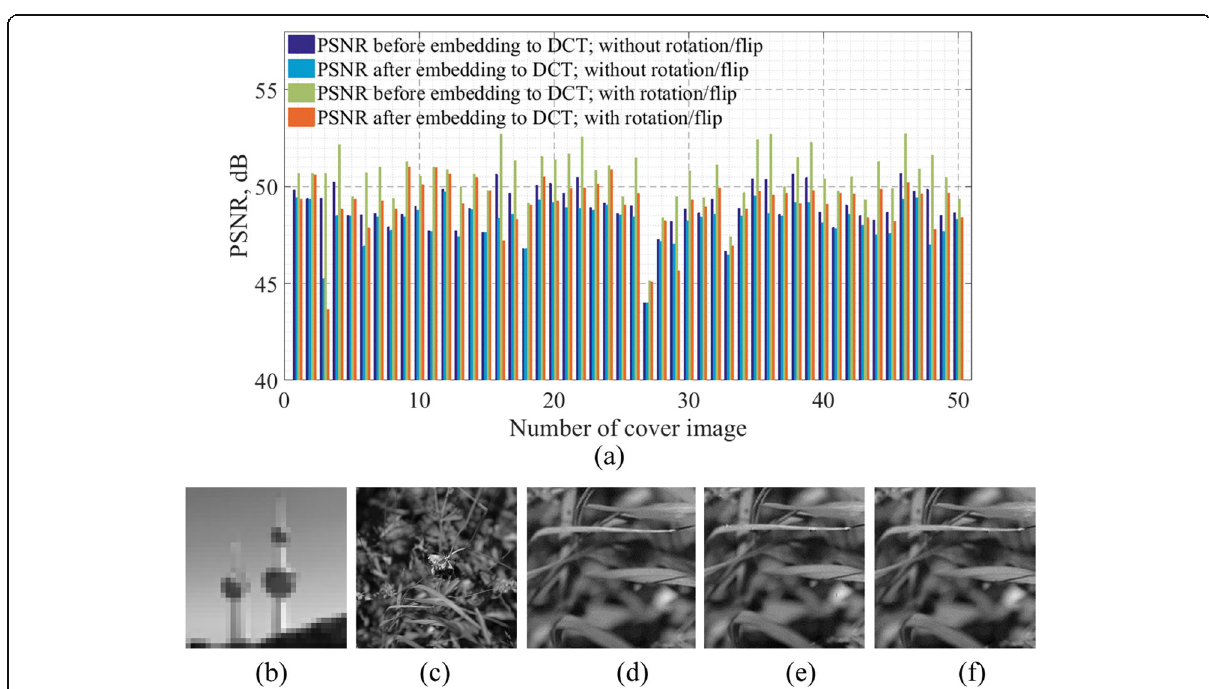
Fig. 4 a PSNR before and after embedding in the DCT domain for the cases with and without manipulations using image local blocks, ( b ) the secret image, 32 × 32, ( c ) an example of a cover image, ( d ) a part of the cover image and ( e ) the same part of the image after spatial embedding without local block manipulations, and ( f ) with local block